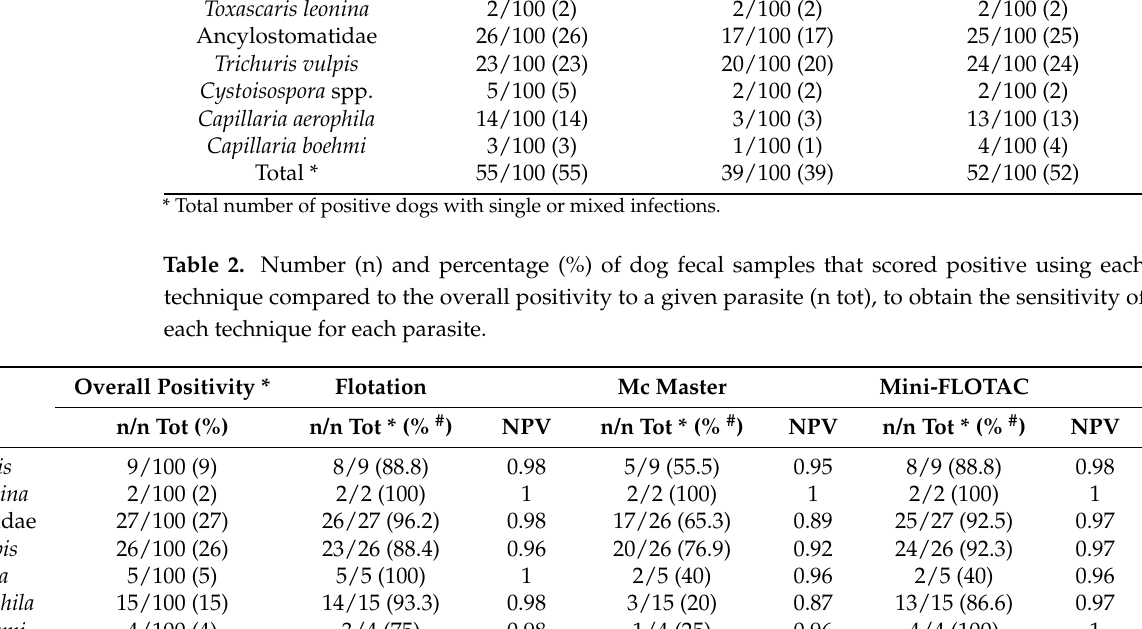
* Regardless of the copromicroscopic technique used; # sensitivity; NPV: Negative predictive value.